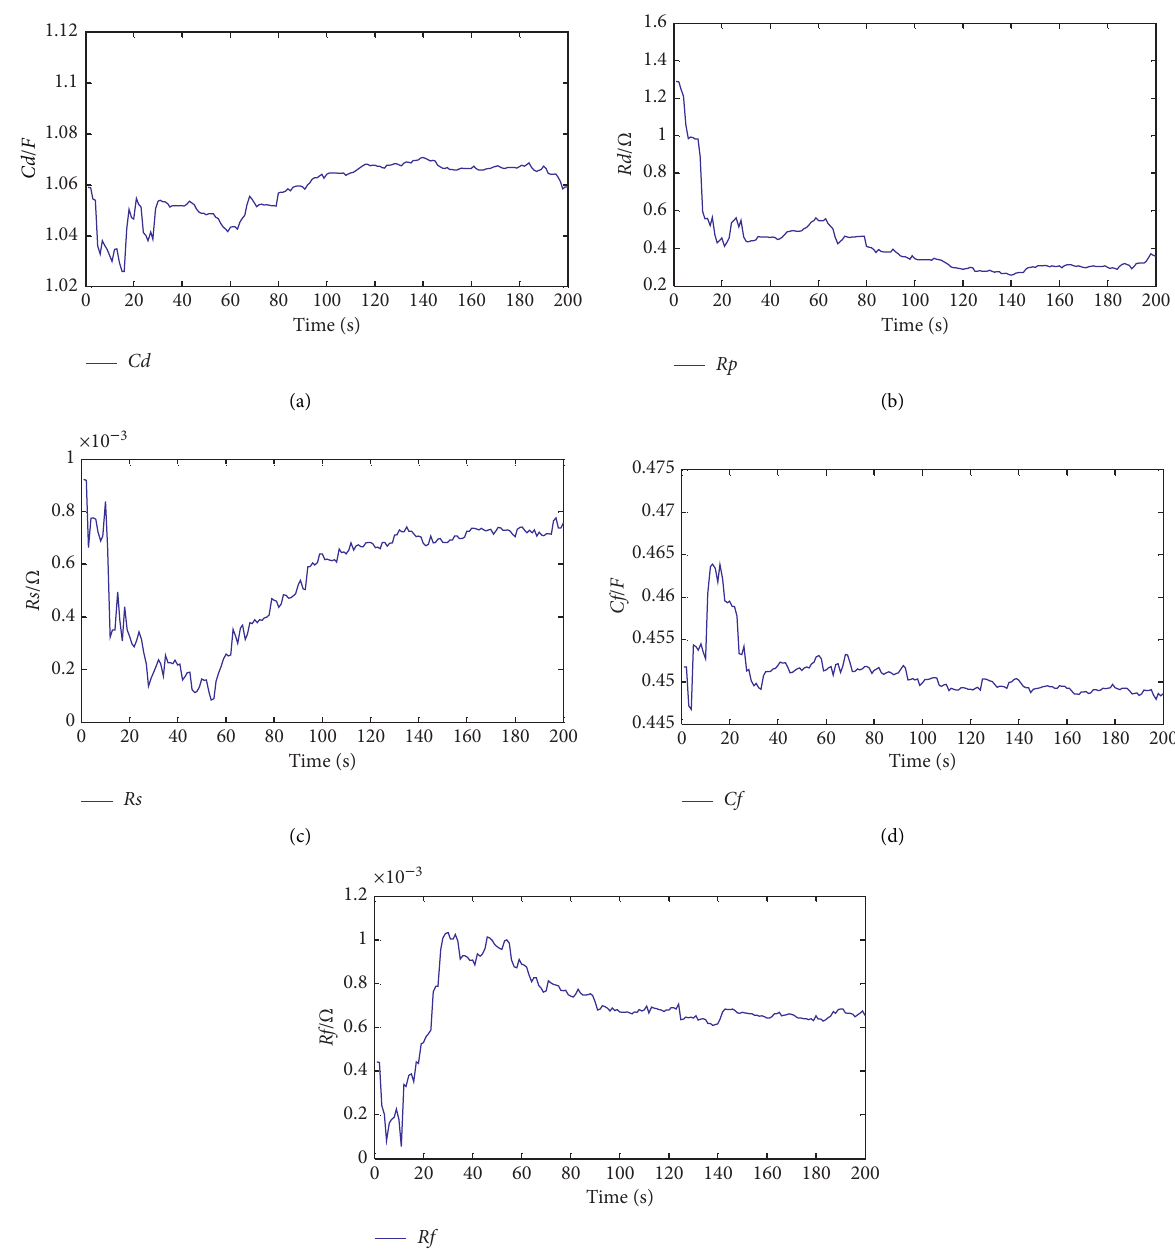
Figure 8: Parameter identification of the supercapacitor model. (a) Identification results of negative capacitance parameter C identification result of equivalent parallel resistance R p ; (c) identification result of equivalent series resistance R s ; (d) identification results of positive capacitance parameter C f ; (e) identification result of Faraday resistance R f